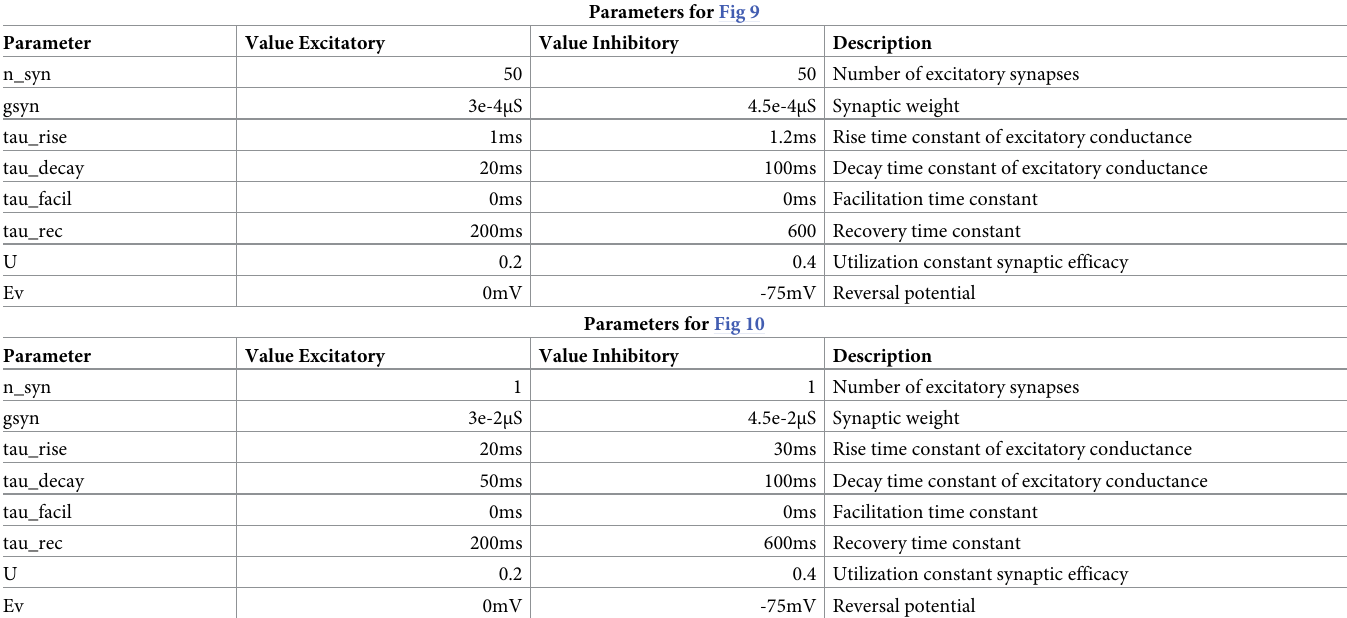
Table 1. Synaptic parameters of morphologically realistic simulations in Figs 9 and 10.